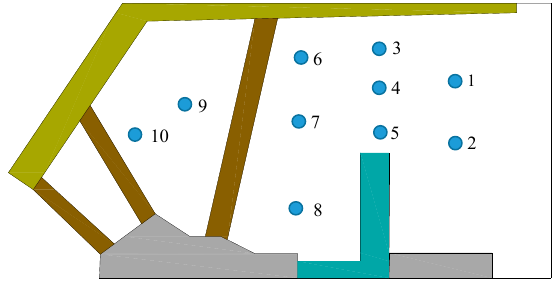
Figure 4. Velocity measurement positions on a cross section. Table 4. Comparison between the measured and modelled velocity.